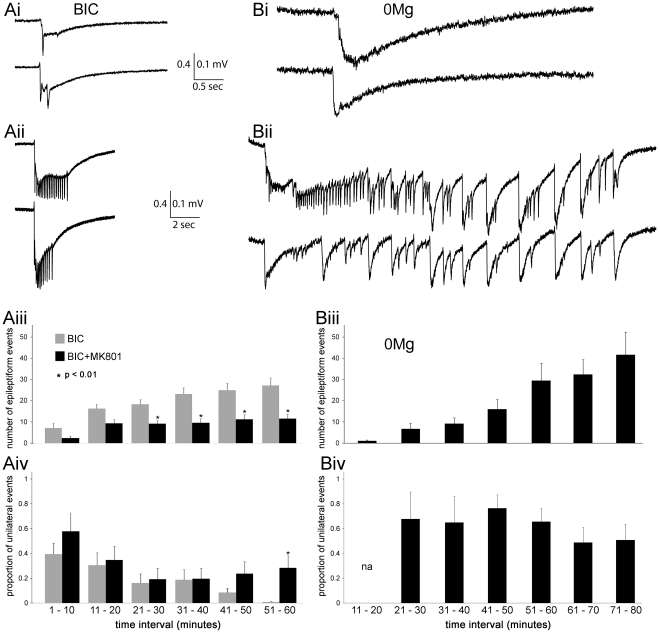
Comparisons of different seizure models in the callosal slice preparation using dual recordings in two hemispheres simultaneously.Representative examples of bilateral EEs recorded in BIC (Ai and Aii) versus 0Mg (Bi and Bii) are shown. In each bilateral EE example, there are two simultaneous recordings, where each recording is gathered from opposite hemispheres in a single slice preparation. Ai and Bi show events that resemble inter-ictal events (5 sec. or less). These were the predominant kind of events recorded overall, and the only kind of event recorded in the BIC recordings. Aii and Bii show the longest event recorded for BIC (approx. 5 sec.), and a typical ictal-like event for 0Mg (approx. 30 sec.), respectively (note differerent time scales in the i vs. ii panels). For all panels, 0.4 mV is the y-scale for BIC, while 0.1 mV represents the y-scale for 0Mg, reflecting the significantly larger amplitudes found for these EEs in BIC. (Aiii) Significant differences in the number of EEs arise between the BIC and BIC+MK801 groups during the course of recordings (Wilcoxon rank sum test). (Aiv) The proportion of EEs that are unilateral decreases more in the BIC group than in the BIC+MK801 group (Chi square test of proportions). Data from both (Aiii) and (Aiv) show mean ± SE. n = 17 paired recordings from 17 slices from 9 mice in the BIC group, while n = 17 paired recordings from 17 slices from 5 mice in the BIC+MK801 group. (Biii) The number of EEs increase during long recordings in 0Mg. Data shown are only from slices that demonstrated any EEs during recordings (n = 27 from a total of 46 slices). (Biv) In contrast to BIC data, there is not a significant decrease in the proportion of unilateral events during long recordings. Data shown are only from slices that demonstrated at least one bilateral EE (n = 13 slices).